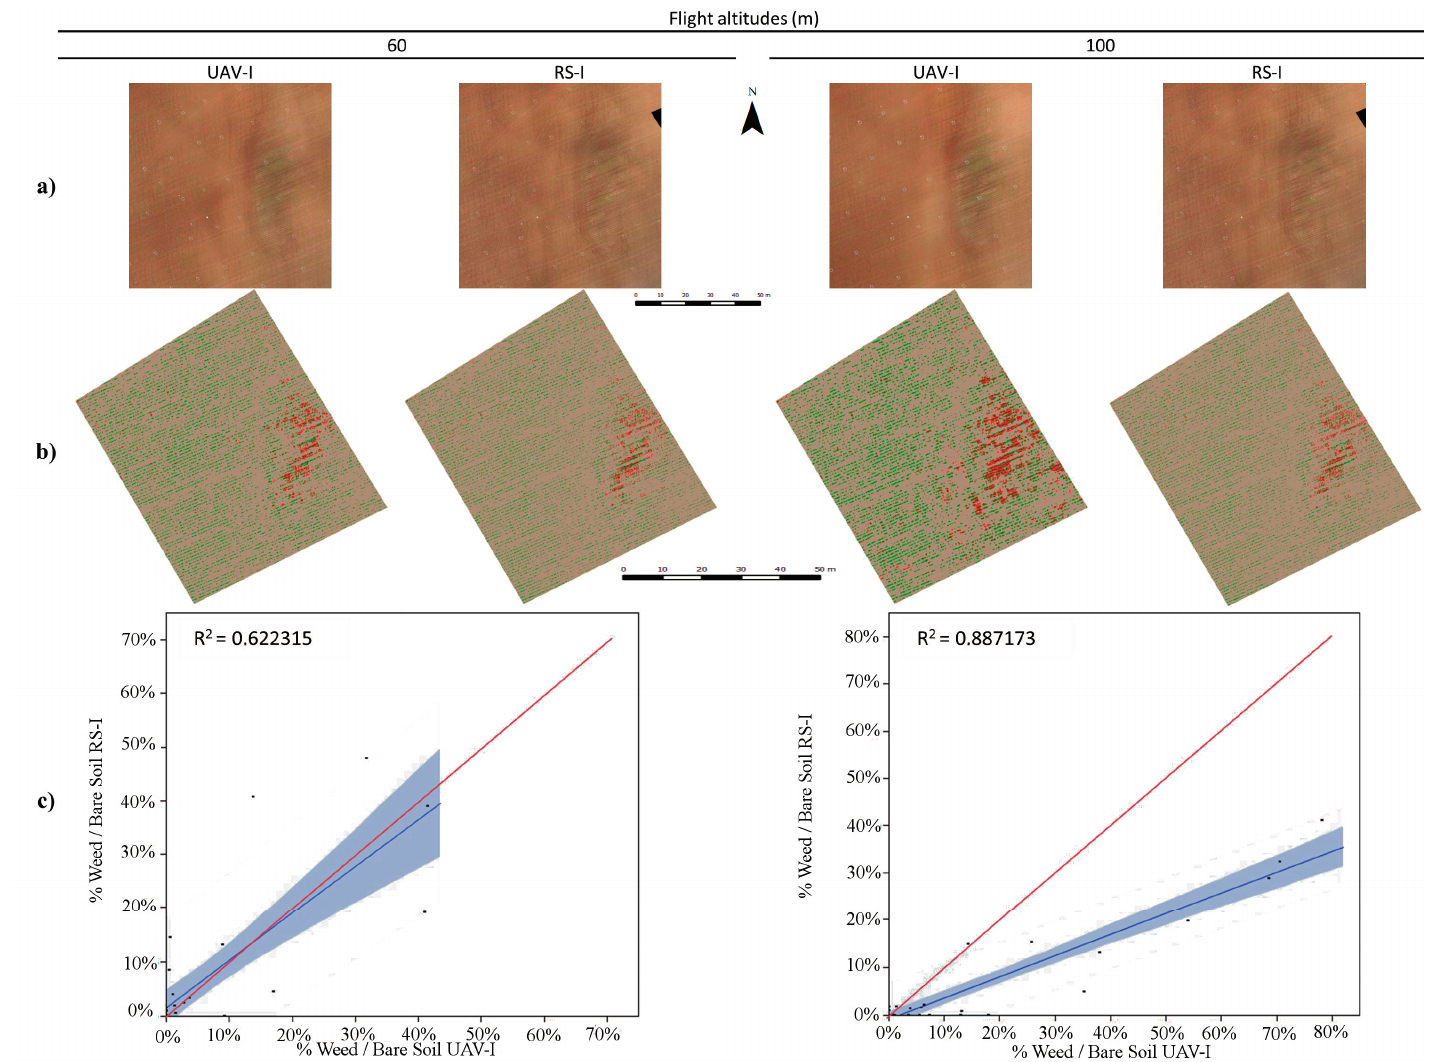
Figure 3. ( a ) Portions of UAV-image taken with the visible camera and RS-image; ( b ) maps obtained using OBIA; and ( c ) graphics comparing UAV-image and RS-image estimated weed cover in the 32 frames established in Field